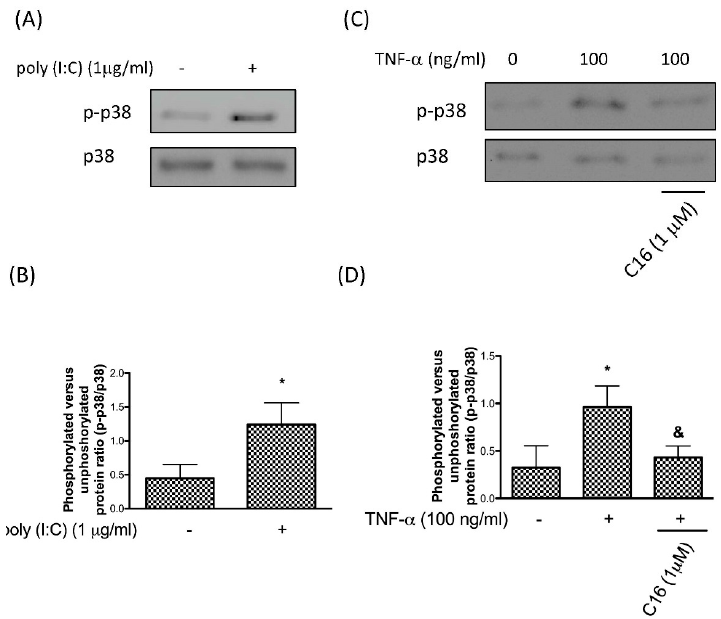
Figure 1. Protein expression ( A ) and the ratio ( B ) of p-p38 after upregulation of PKR using poly (I:C); protein expression ( C ) and the ratio ( D ) of p-p38 after exogenous administration of TNF- α for 12 h in human chondrocytes with or without PKR inhibitor C16 ( n = 3; * p < 0.05 compared to control group. p < 0.05 compared to TNF- α group, p values were generated by ANOVA using the Tukey’s test). Antioxidants 2019 , 8 , x FOR PEER REVIEW